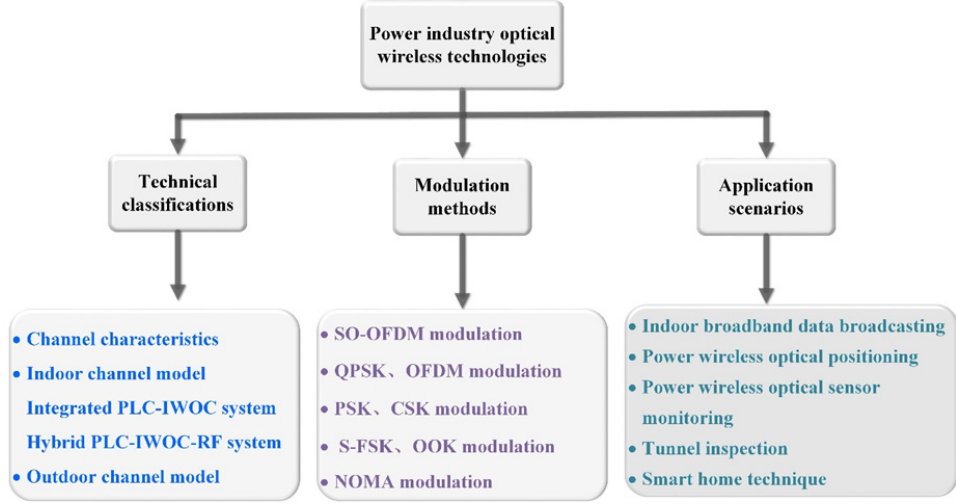
Figure 2. Block diagram of the power industry optical wireless technologies.